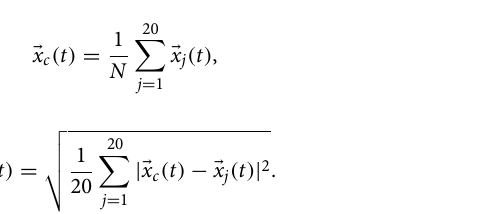
Figure 4. ( a ) Schematic representation of the definition of ˜ R (Eq. 6). Players in two teams are represented by red rightward and blue leftward triangles. The cross and star markers represent the end points of respectively. The dotted line indicates the circle with radius σ( t o ) . This case corresponds to ˜ R > 1 , meaning that the end point of the pass is located outside the formation. ( b ) Relationship between ˜ R and z 2 ( is the threshold that determines whether the location the spaces with z 2 (cid:31) 2 and z 2 (cid:31) 2 as sparse and dense,